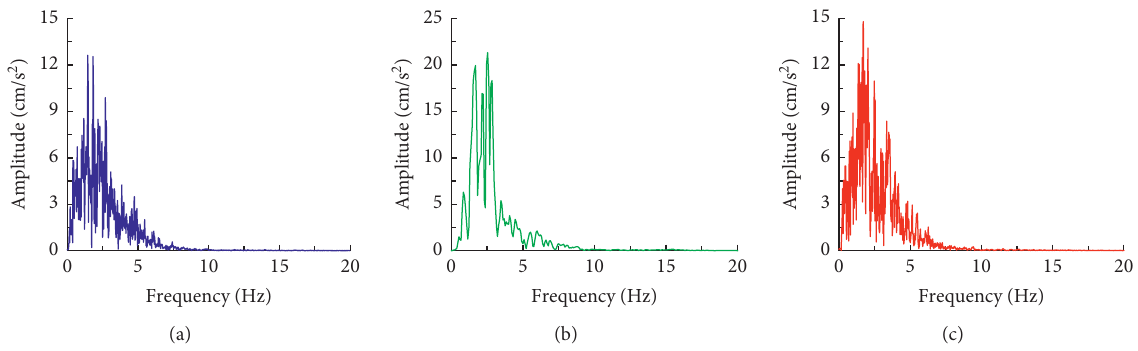
Figure 12: Corresponding frequency spectra of waves. (a) El Centro wave. (b) Kobe wave. (c) Taft